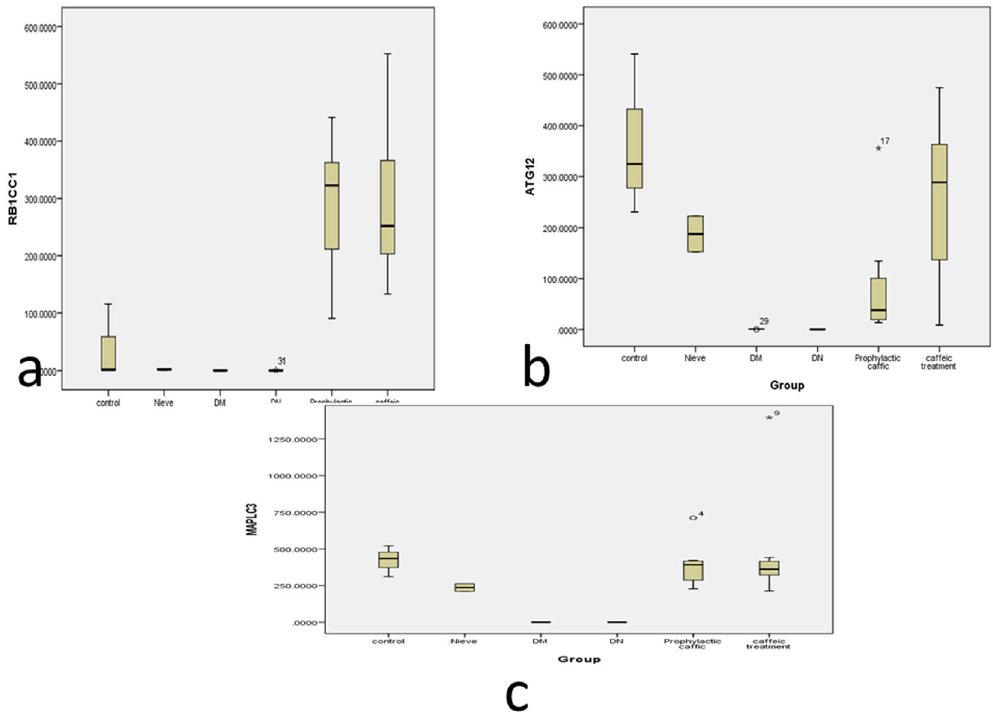
Figure 4. RB1CC1, ATG12, MAP1LC3B expression in Kidney tissue at the end of the 12 weeks in the Control, Naive, Diabetes mellitus group, Diabetic nephropathy group, caffeic acid Prophylactic group, caffeic acid Treated group. ( A ) RB1CC1 mRNA; ( B ) ATG12 mRNA; ( C ) MAP1LC3B . Data are presented as fold change, where * indicates P < 0.05 compared to the control group (One way ANOVA followed by Bonferroni’s multiple comparison test), N =